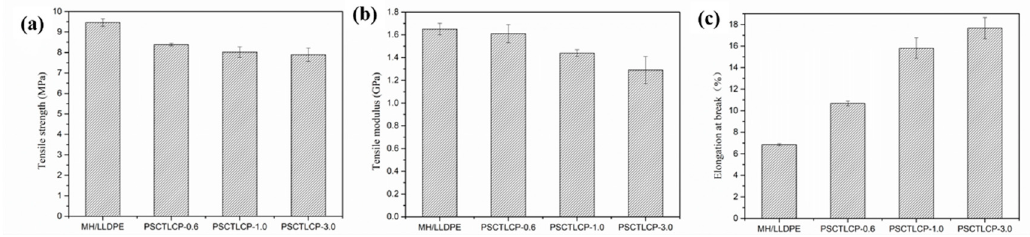
Figure 11. Variation of ( a ) tensile strength, ( b ) tensile modulus, and ( c ) elongation at break with the PSCTLCP